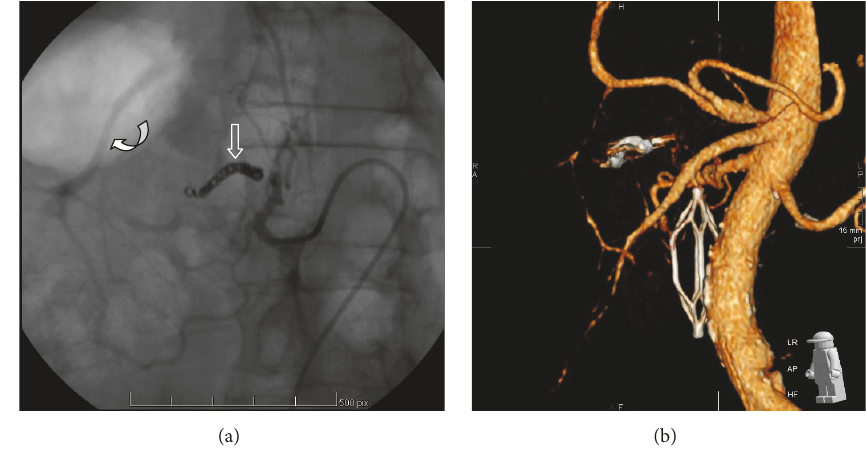
Figure 5: Selective angiography after coil embolization : (a) Microcoils (Arrow) proximal and distal to the origin of the aneurysm. Adequate retrograde collaterals to the liver through the posterior branch are also shown (Curved arrow) . (b) Three-dimensional reconstruction on follow-up CT scan, showing persistent occlusion of the aneurysm, with patent hepatic